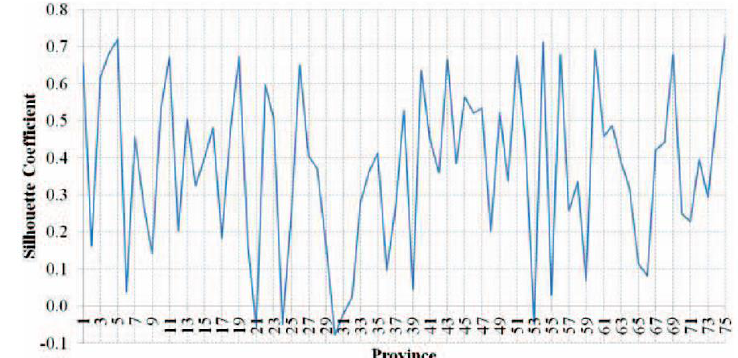
Figure 15. Silhouette coefficients for k = 5 and square Euclidean distance measure result [16].